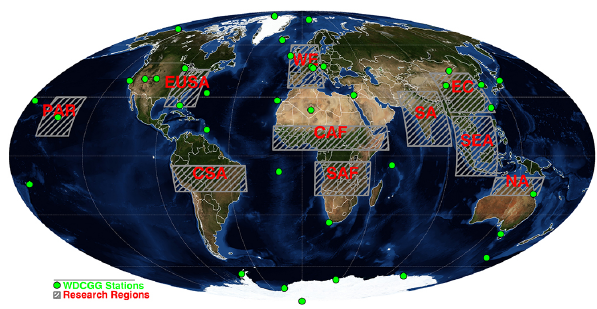
Figure 3. Research region domains and geolocations of WDCGG stations listed in Tables 1 and 2,